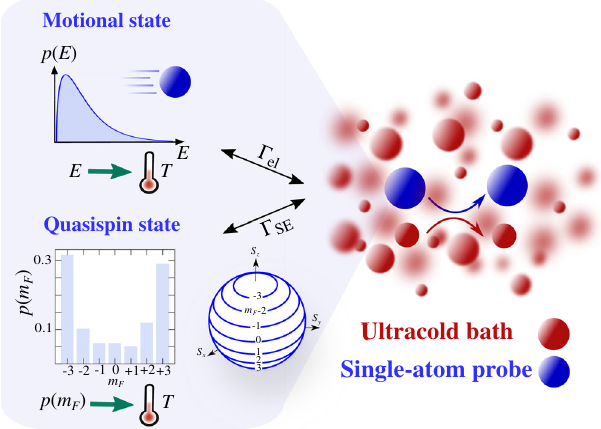
FIG. 1. Single-atom quantum probing of an ultracold gas. A single atom is coupled to the bath, interacting via two processes. First, elastic collisions at rate Γ thermalize the probe to the el temperature of the bath, where the kinetic energy distribution allows for classical thermometry (top). Second, spin-exchange collisions at rate Γ ensure motion-spin mapping and allow us to SE store information on the bath energy in the quantum states of the probe, here the quasispin states visualized by a macroscopic Bloch sphere